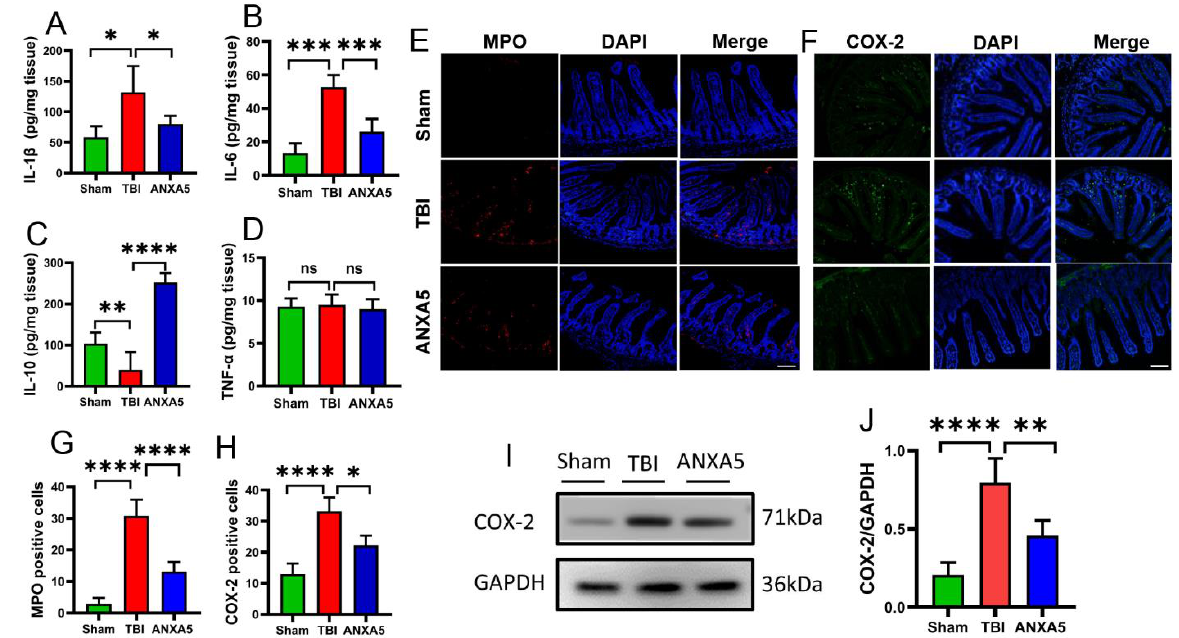
Figure 3. ANXA5 alleviated intestinal inflammatory response after TBI. ( A – D ) ELISA results showed that ANXA5 decreased the pro-inflammatory cytokines IL-1 β and IL-6, but increased the anti-inflammatory cytokine IL-10 in the intestine on day 2 after TBI ( n = 6 mice/group). ( E – H ) ANXA5 decreased the numbers of MPO-positive and COX-2-positive cells (in red) in the intestine on day 2 after TBI. Insets show merged images of MPO and COX-2 staining with DAPI-stained nuclei (scale bar = 100 µ m, n = 6 mice/group). ( I , J ) Western blotting showed that ANXA5 treatment significantly reduced the expression of COX-2 ( n = 6 mice/group). Data are shown as mean ± SD. * p < 0.05, ** p < 0.01, *** p < 0.001, **** p < 0.0001.